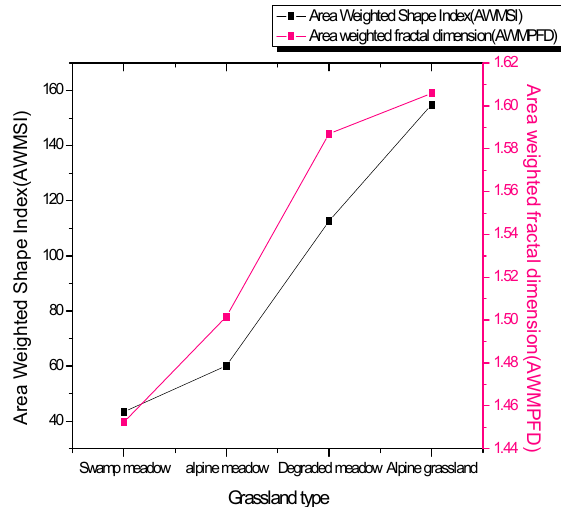
Figure 6. AWMSI and AWMPFD of four kinds of